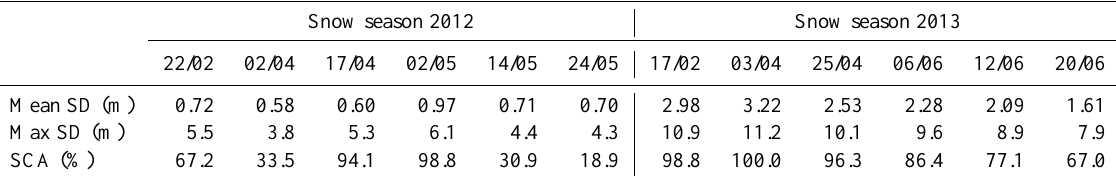
Table 1. Summary statistics of the snowpack distribution and the snow covered area of the basin. Note that the snow covered area is expressed as a % of the total area surveyed by the TLS, and the mean SD is the average of all SDs not including zero